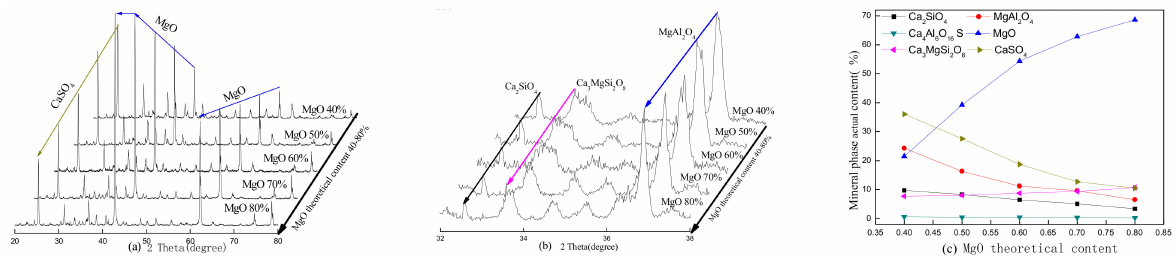
Figure 4. XRD patterns of the SAC-MKPC clinker with MgO theoretical content at 1200 ◦ C: ( a ) main phase; ( b ) minor phase; and ( c ) mineral phase actual content.